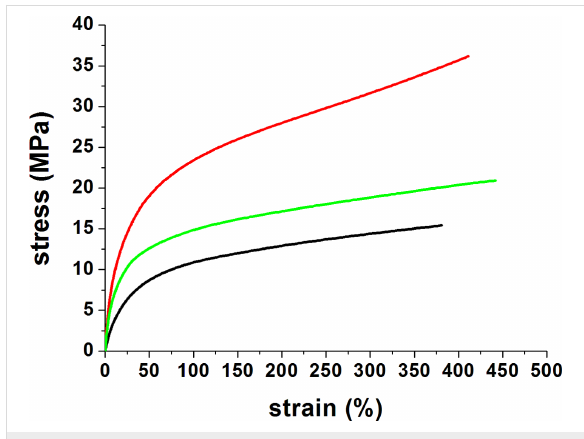
Figure 3: Strain-–stress curves of PVA film without gold nanostars (black); PVA film with gold nanostars coated with SH-PEG–COOH (red) and PVA film with gold nanostars coated with SH-PEG–OCH 3 (green).